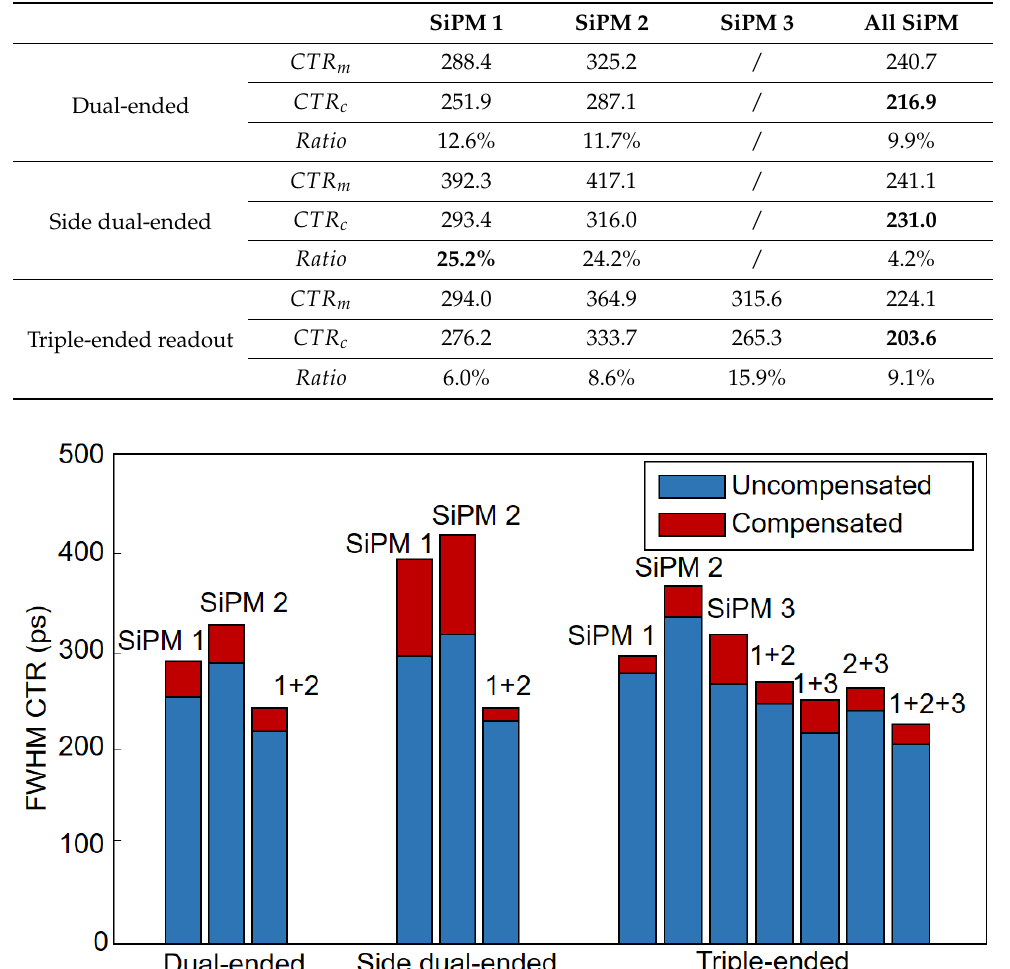
Figure 11. The FWHM CTRs of the tested